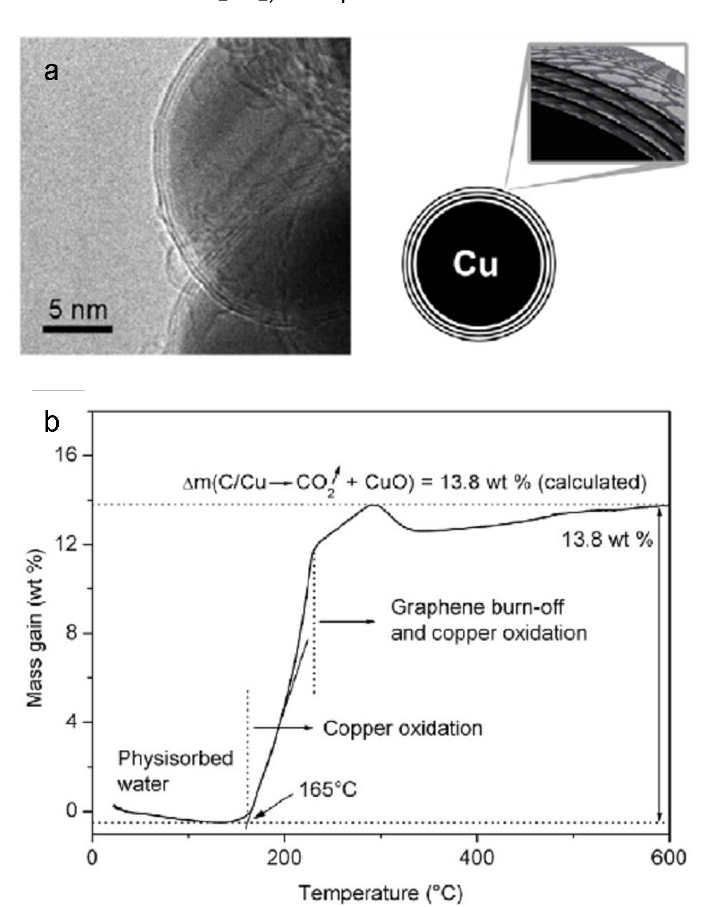
Figure 1. ( a ) Transmission electron microscope ( TEM) image of a single copper NP with a thick graphene layer of 3 nm (left) and a corresponding schematic illustration (right); ( b ) Thermogravimetric analysis (TGA) confirms the thermal stability of these NPs up to 165 °C. Reprinted from reference [16], with permission from IOP Publishing